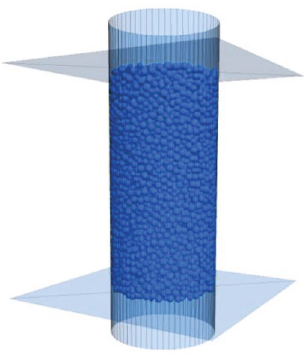
Figure 5: Model of the particle fl ow numerical